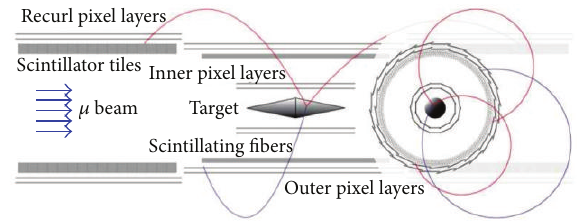
Figure 20: Layout of the Mu3e experiment.